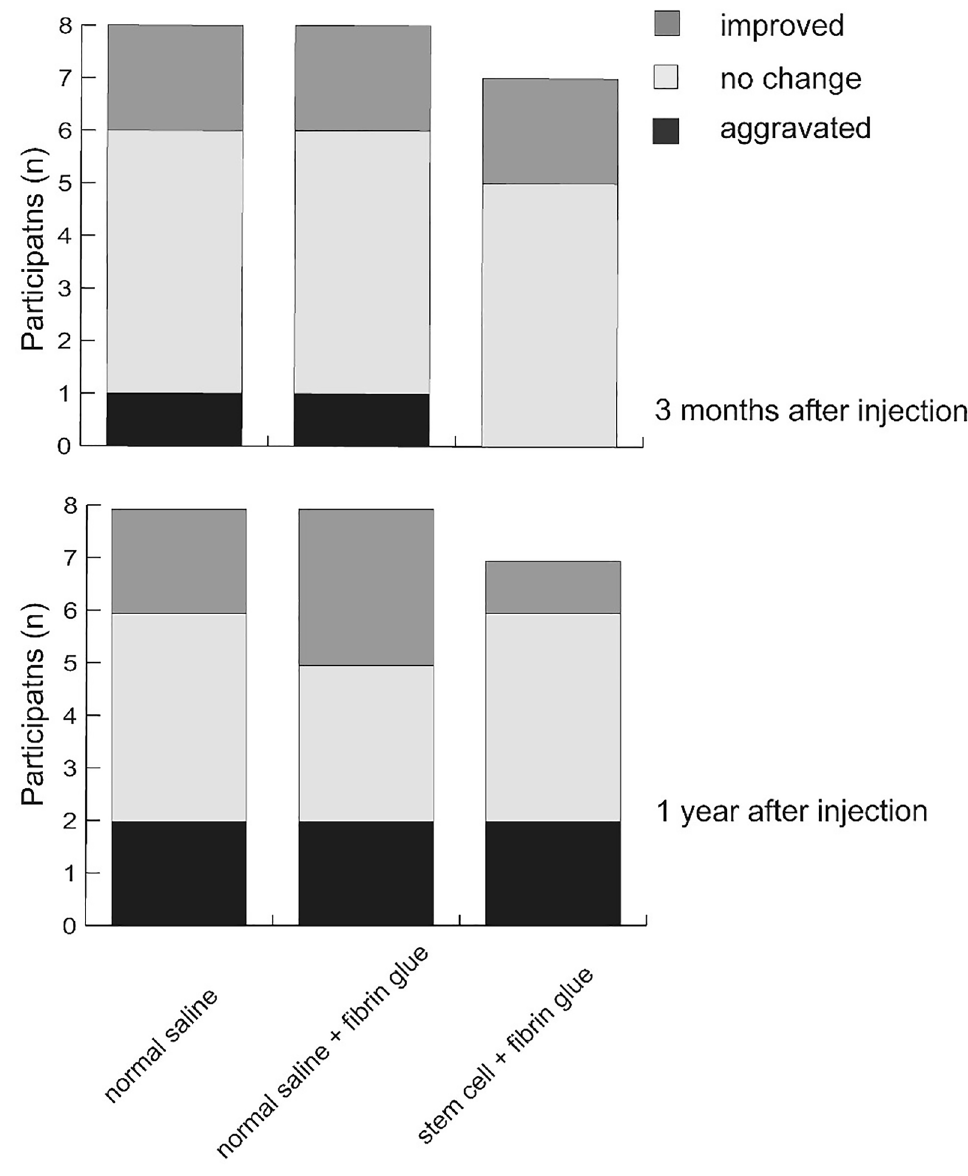
Figure 3. Subjective grading of tear size compared with baseline